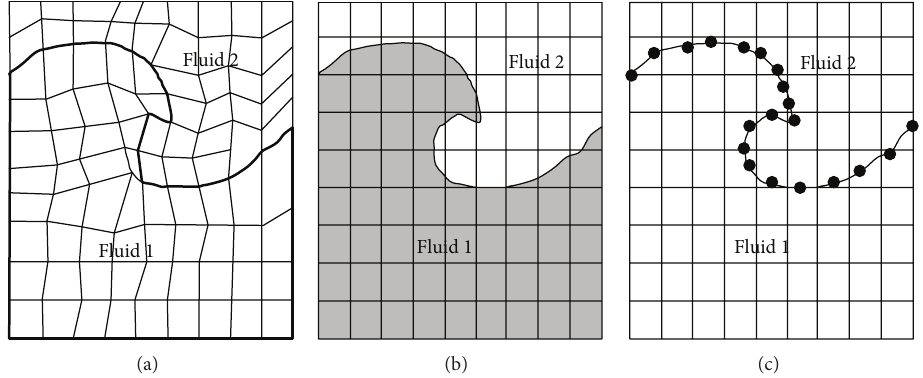
Figure 3: Three approaches to compute free surface flows: (a) surface fitting, (b) surface capturing, and (c) surface tracking.